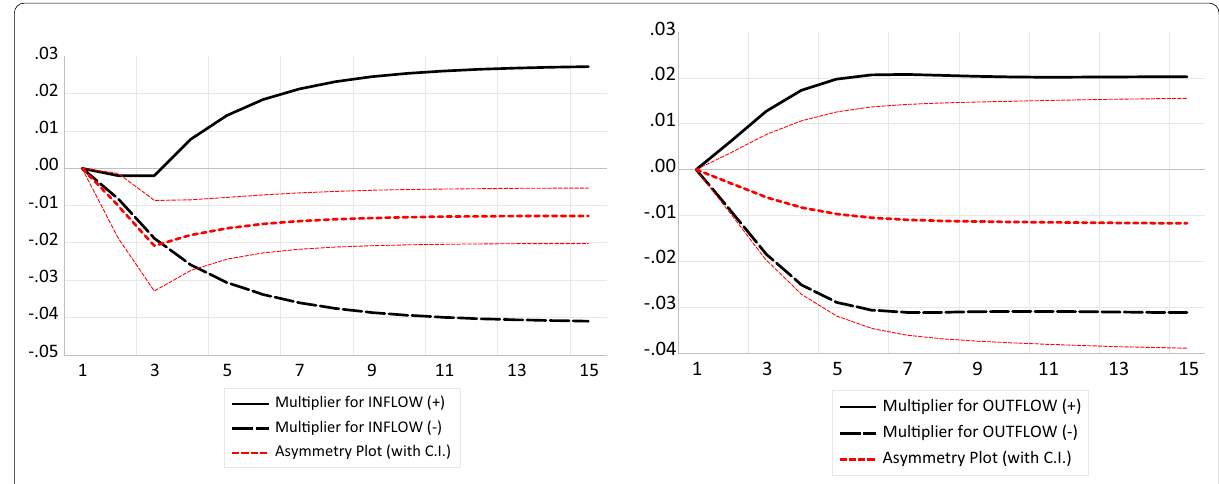
Fig. 1 Multiplier graph for model specification 2, Multiplier graph for model specification